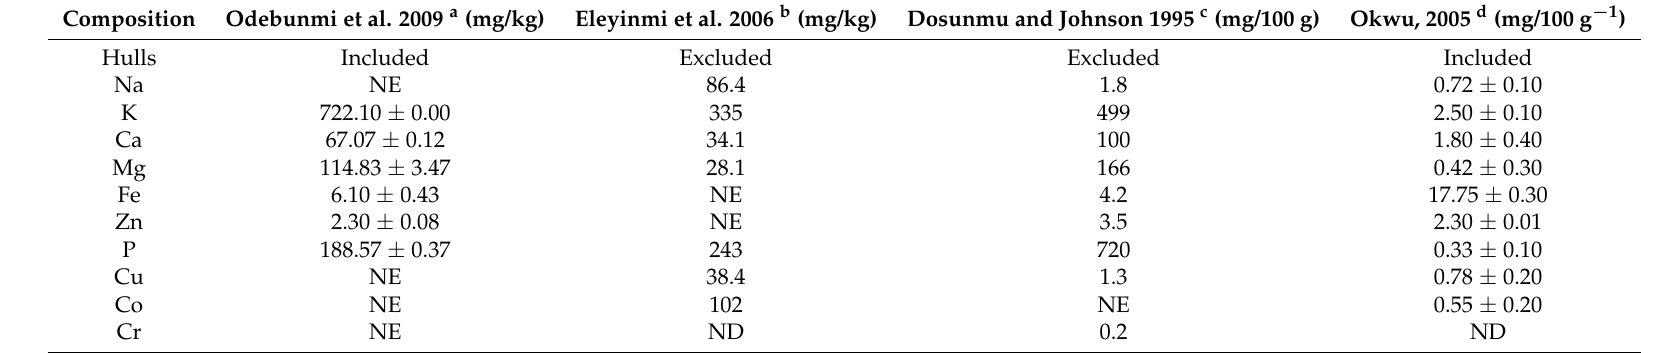
Table 3. Mineral composition of G. kola